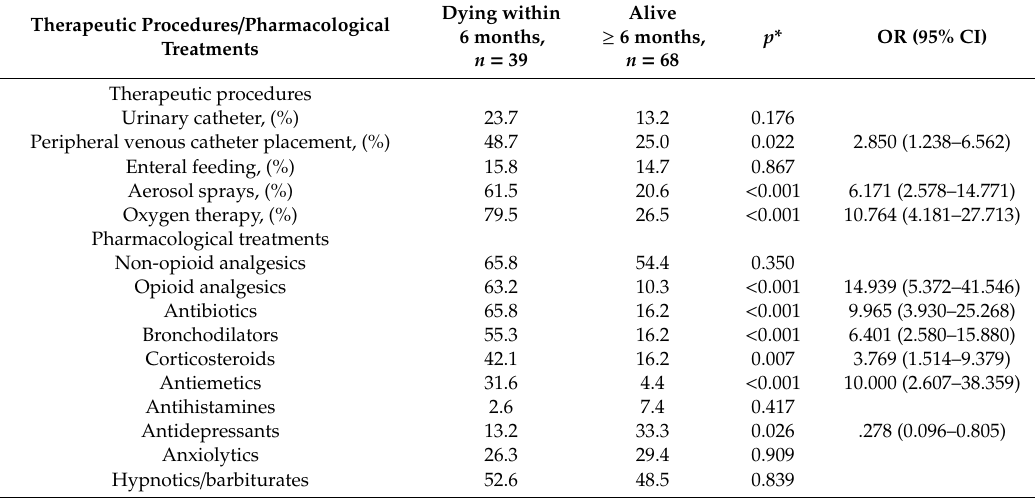
Table 5. Comparison of therapeutic procedures and pharmacological treatments in nursing home patients who died with those who did not